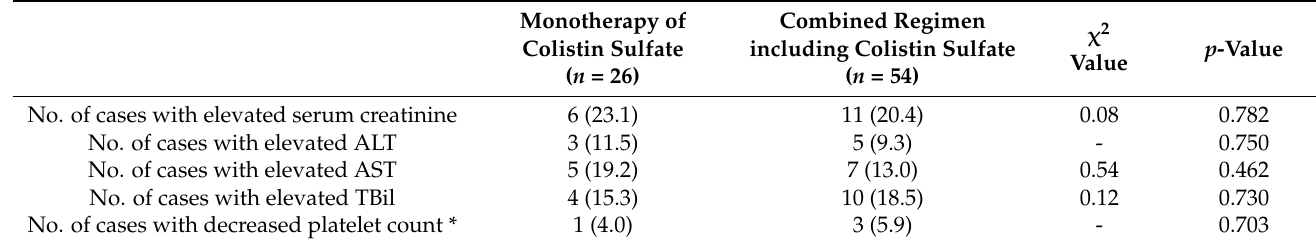
Table 4. Antimicrobial safety comparison between the monotherapy and combination therapy group (No. (%)).